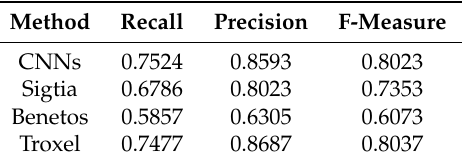
Table 3. Performance on piano